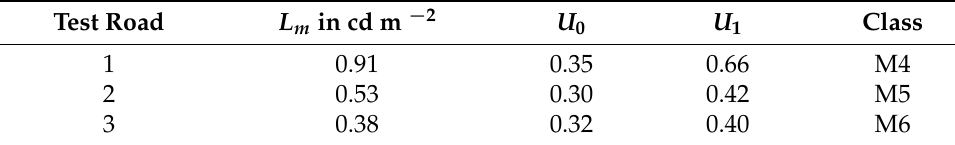
Figure 2. Luminance images of the test roads on which the study was conducted: ( top left ) test road 1 (0.91cdm − 2 , M4 class); ( top right ) test road 2 (0.53cdm − 2 , M5 class); ( bottom ) test Road 3 (0.38cdm − 2 , M6 class). From the luminance images, the homogeneity differences are obvious. Table 1. Characteristics of the test